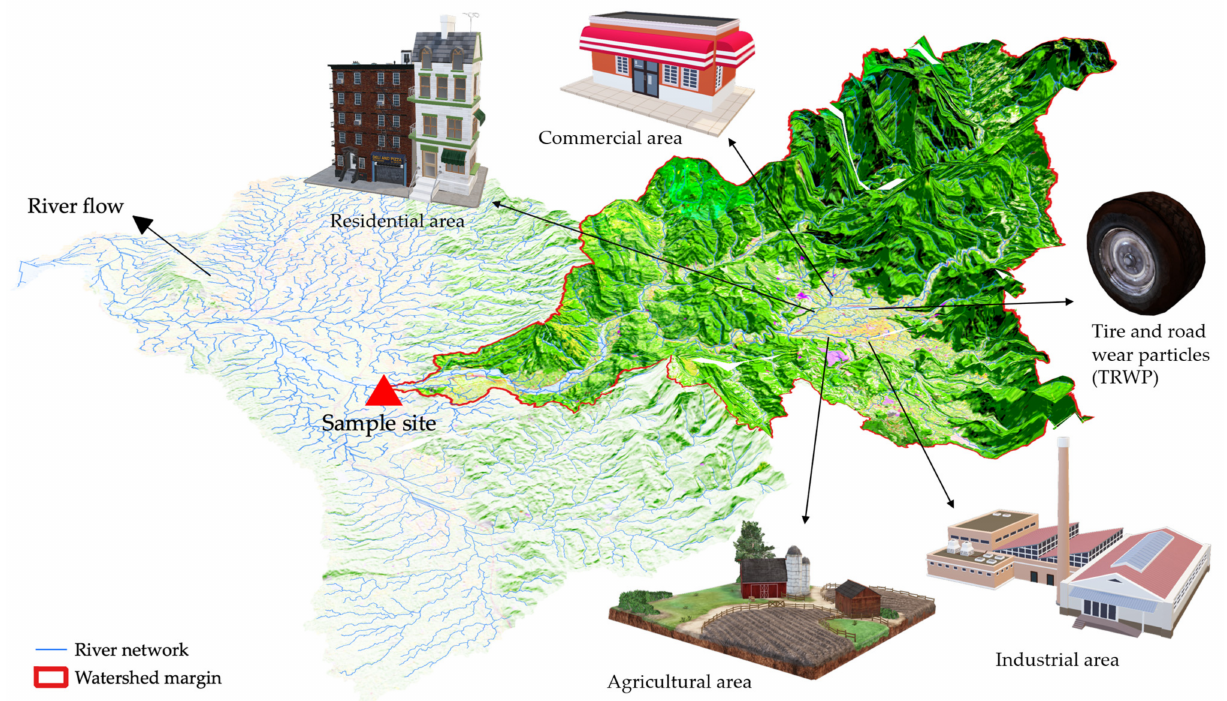
Figure 2. Watershed margin delineation of sample sites and different upstream land covers. Three- dimensional objects were retrieved from Microsoft ® Office PowerPoint ®